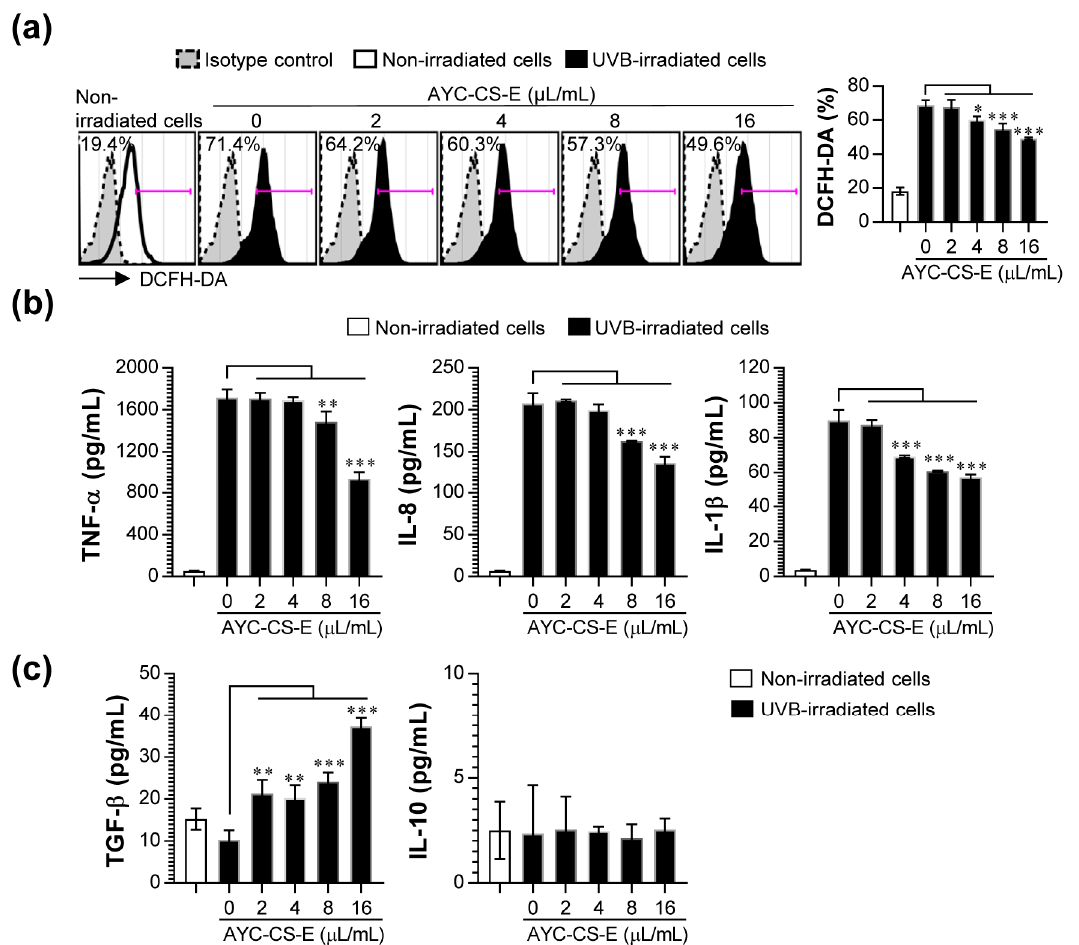
Figure 5. Effect of AYC-CS-E treatment on reactive oxygen species (ROS) production, and pro- and anti-inflammatory cytokine secretion of UVB-irradiated HaCaT cells. ( a – c ) HaCaT cells were treated with various concentrations (2, 4, 8, or 16 μ L/mL) of AYC-CS-E (30 mg/mL) for 24 h after being exposed to 8 mJ/cm 2 UVB irradiation. ( a ) Cells were harvested, and intracellular ROS levels were analyzed by 5 μ M 2 ′ ,7 ′ -dichlorofluorescein diacetate (DCFH-DA) staining, as described in the Materials and Methods section. ( b, c ) The culture supernatants were collected, and pro- (( b ) Tumor necrosis factor- α (TNF- α ), Interleukin-8 (IL-8), and IL-1 β ) and anti-inflammatory cytokine (( c ) transforming growth factor beta (TGF- β ) and IL-10) levels were analyzed using cytokine-specific ELISA kits. All bar graphs show the means ± standard deviation (SD) of 3 samples. One representative plot out of three independent experiments is shown. * p < 0.05, ** p < 0.01, or *** p < 0.001.